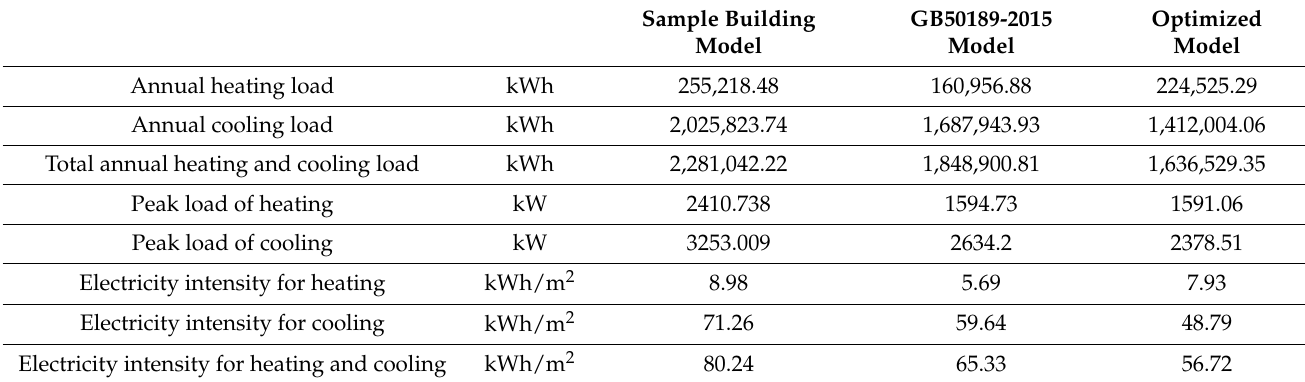
Table 11. Annual energy performance of the sample building model, the GB50189-2015 model, and the optimized